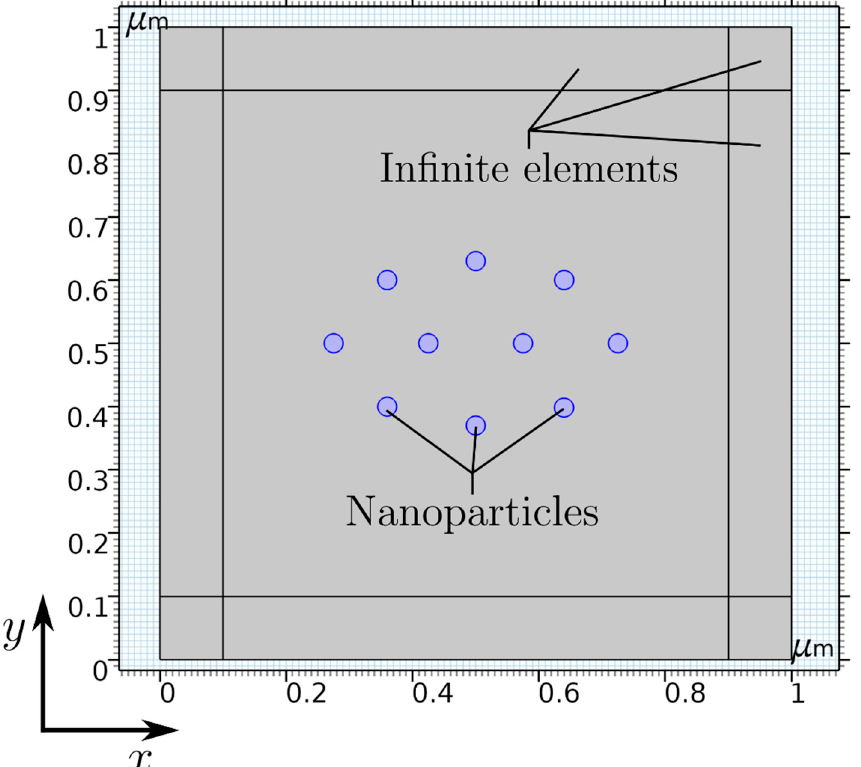
Figure 1. Simulation setup of 10 symmetrically distributed nanoparticles in a 2D computational domain with infinite elements in COMSOL Multiphysics.